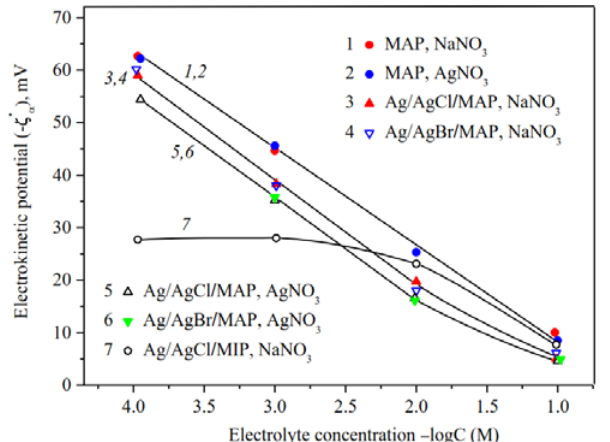
Figure 11. Electrokinetic potential of the base (Ermakova, 2022. Ref. [34]), Ag/AgHal/MAP and Ag/AgCl/MIP membranes vs. the concentration of NaNO 3 and AgNO 3 solutions.